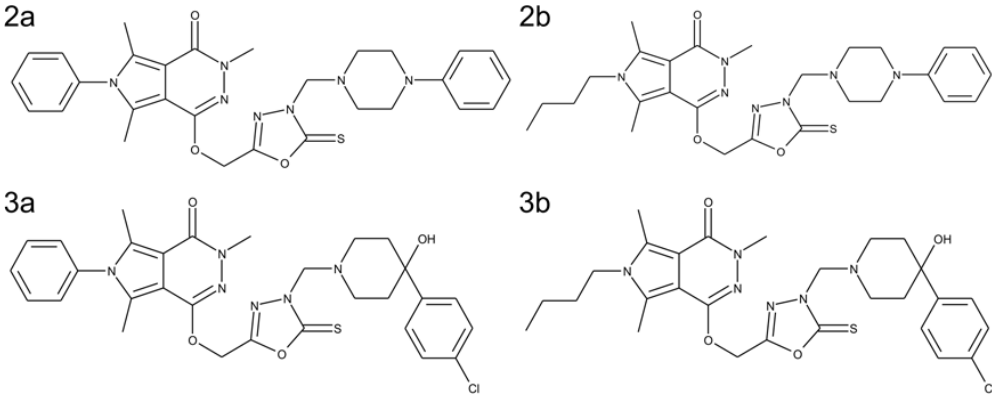
Figure 1. Structures of tested pyrrolo[3,4- d ]pyridazinone derivatives: ( 2a )